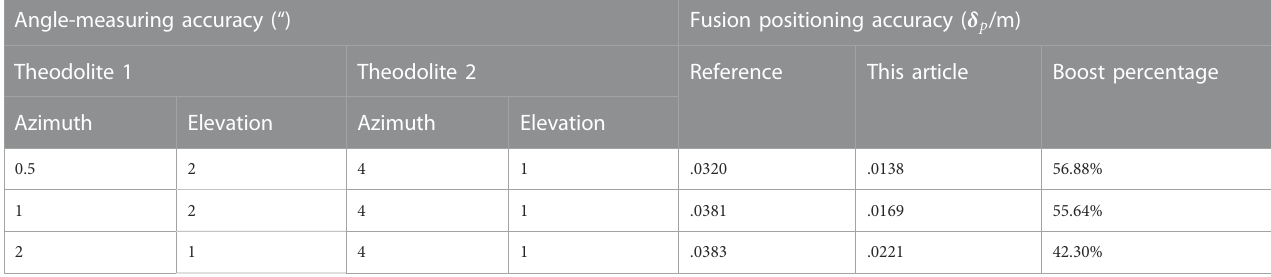
TABLE 3 Comparison of the measurement accuracy between the formulas in this paper reference. Angle-measuring accuracy ( “ ) Fusion positioning accuracy ( δ p /m) Theodolite 1 Theodolite